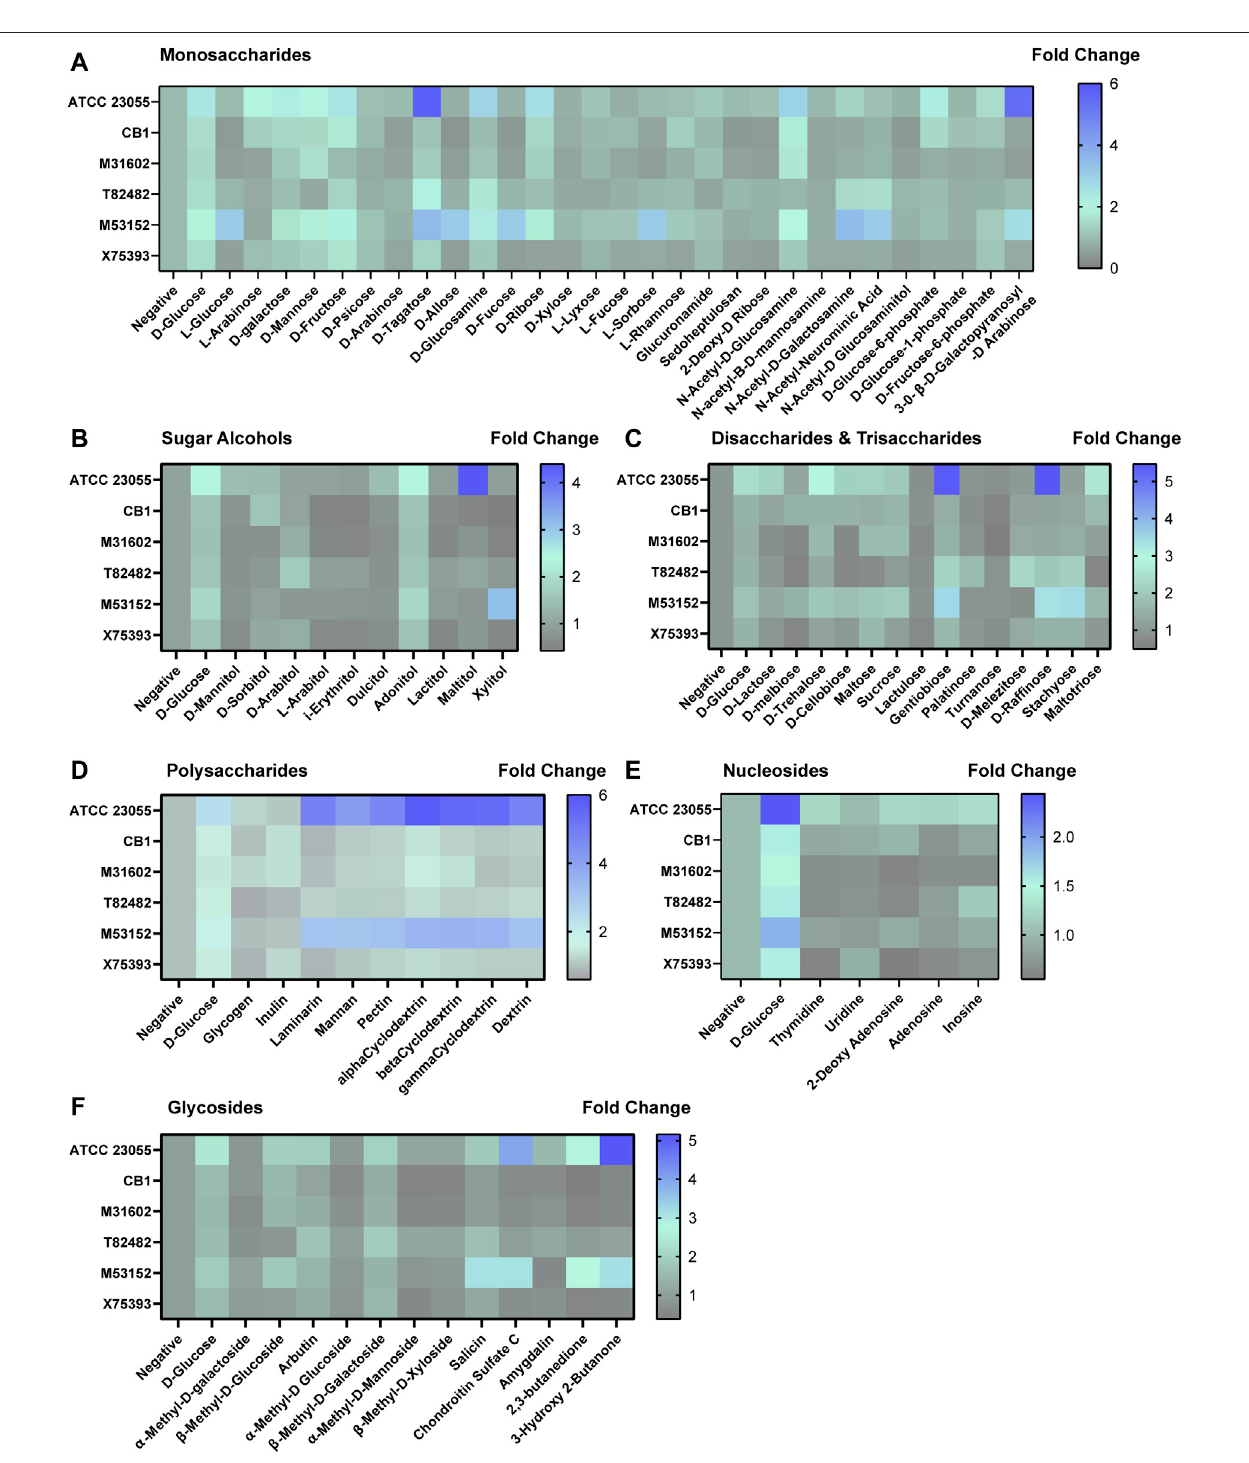
FIGURE5| Acinetobacter growthinvaryingcarbon sources. Heatmapsrepresentingfoldchangeingrowthwiththenegative control(noaddednutrients)setat 1. Growth was examined with (A) monosaccharides, (B) sugar alcohols, (C) disaccharides and trisaccharides, (D) polysaccharides, (E) nucleosides and (F) glycosides after 18 h incubation.